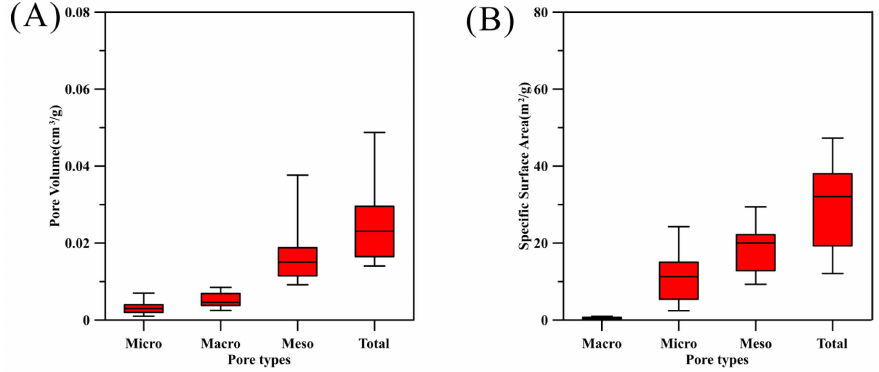
Figure 8. Validity analysis of PV ( A ) and SSA ( B ) data for different types of